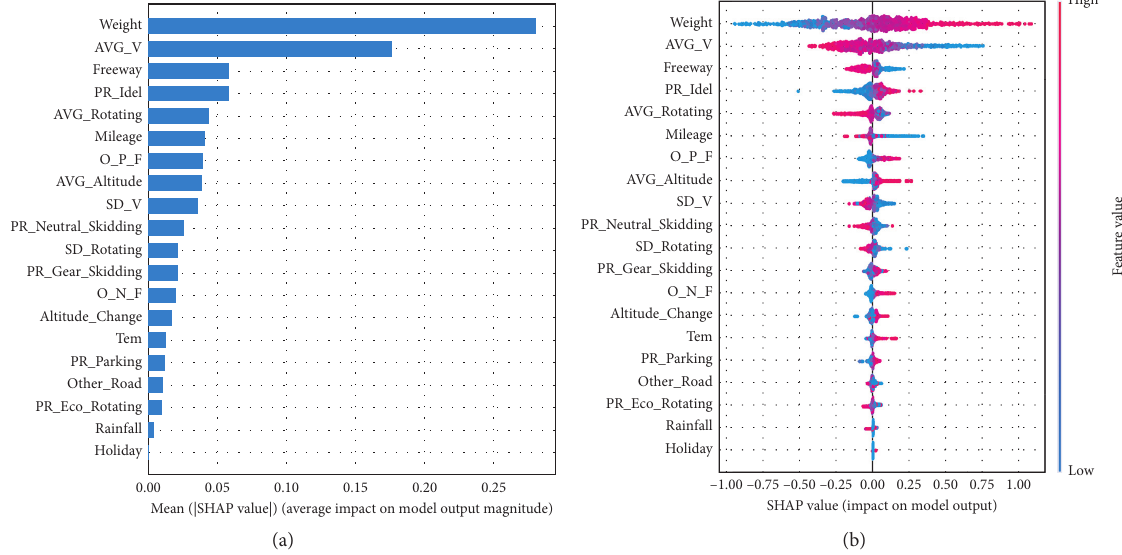
Figure 5: SHAP summary plot for fuel consumption based on the XGBoost model.